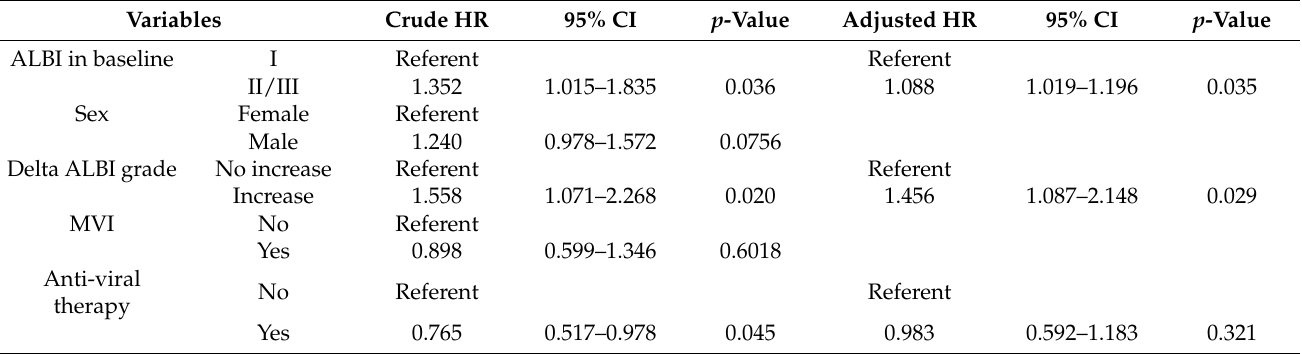
Table 4. Cox regression of risk factors associated with recurrence in HCV